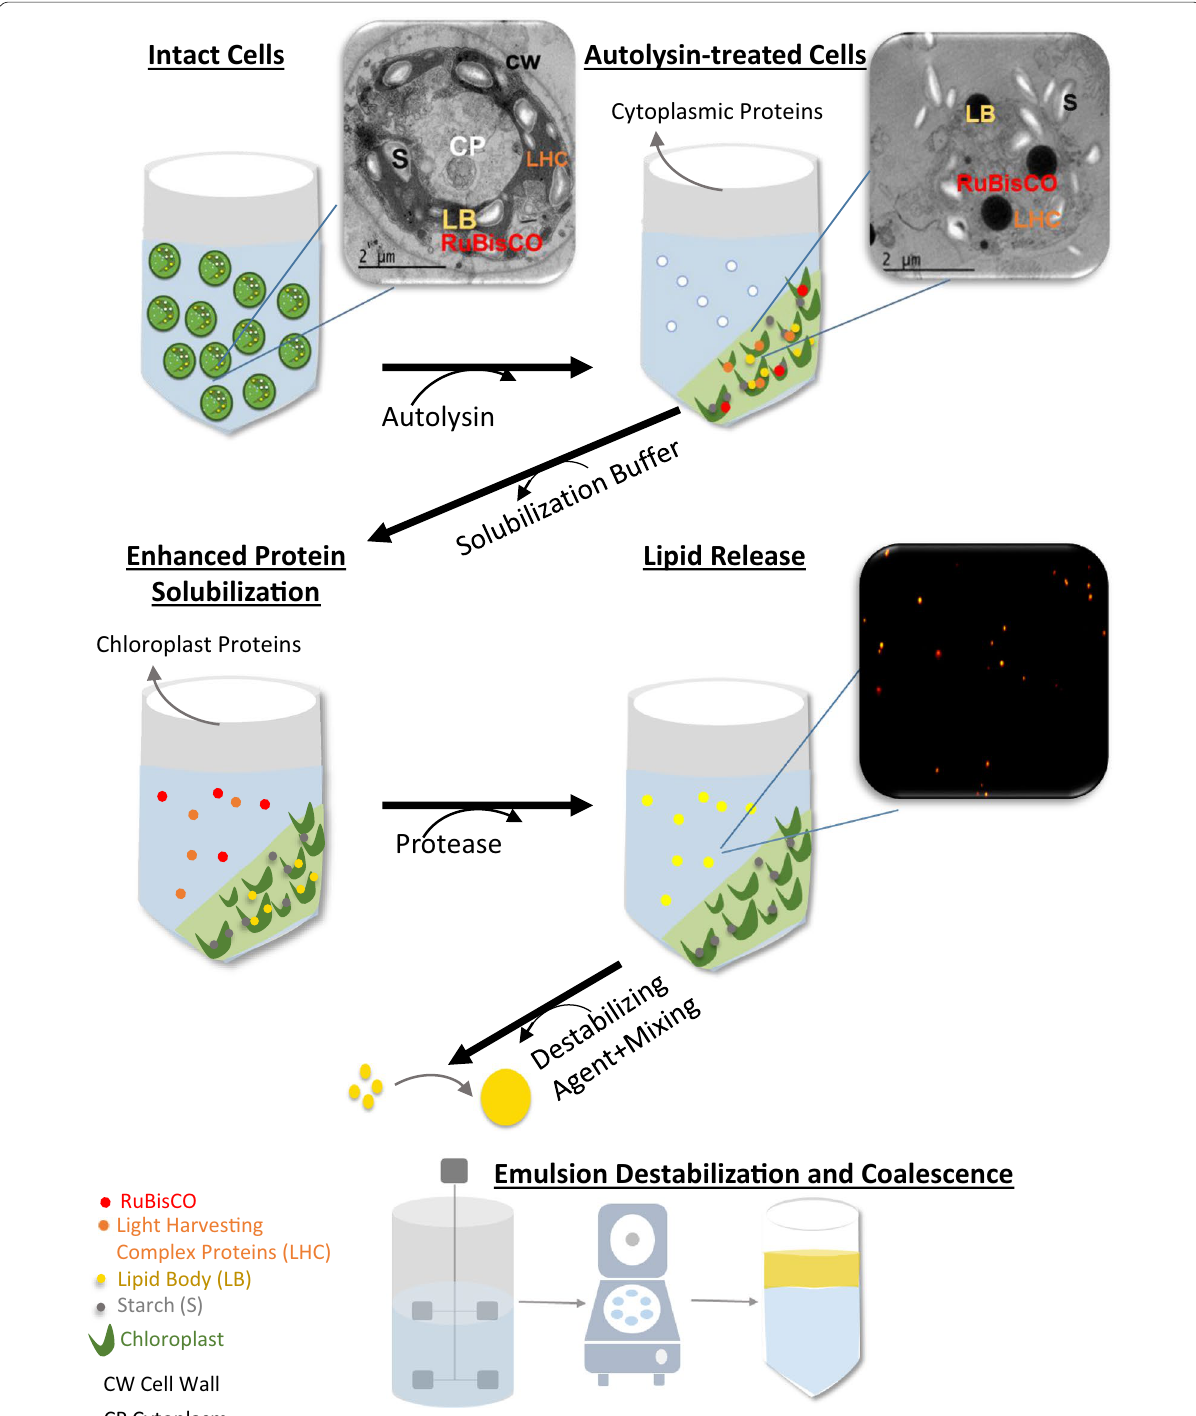
Fig. 4 An alternative and holistic approach to aqueous enzymatic processing of microalgae for